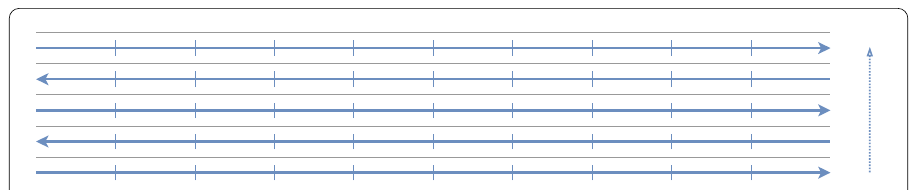
Figure 5 Beam path in Example 1: 5 hatch lines with length 5 mm. The path consists of 50 segments that are separated by the small ticks. The line offset (i.e., the distance between two adjacent lines) is 200 μ m. The thin gray lines indicate the secondary path C wd .